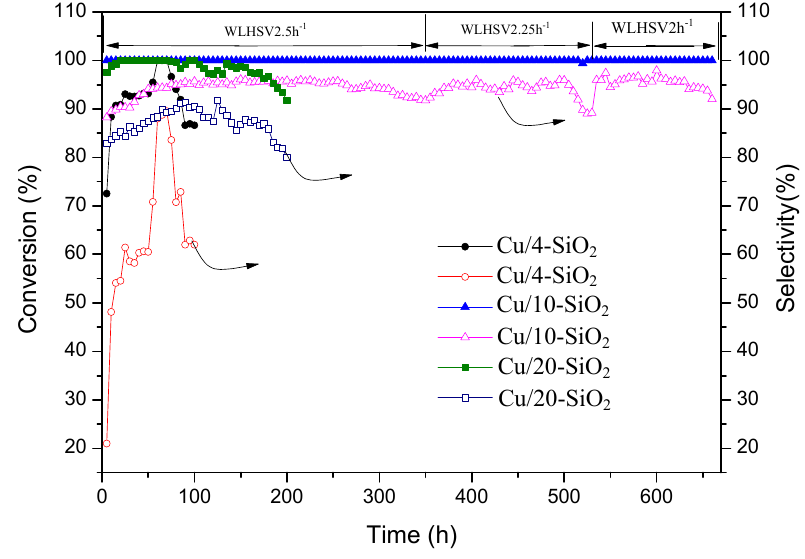
Figure 7. Long-term experiments of Cu/ x -SiO 2 ( x = 4, 10, 20) catalysts. Table 4. Comparison of long-term experiments for EG synthesis from DMO.